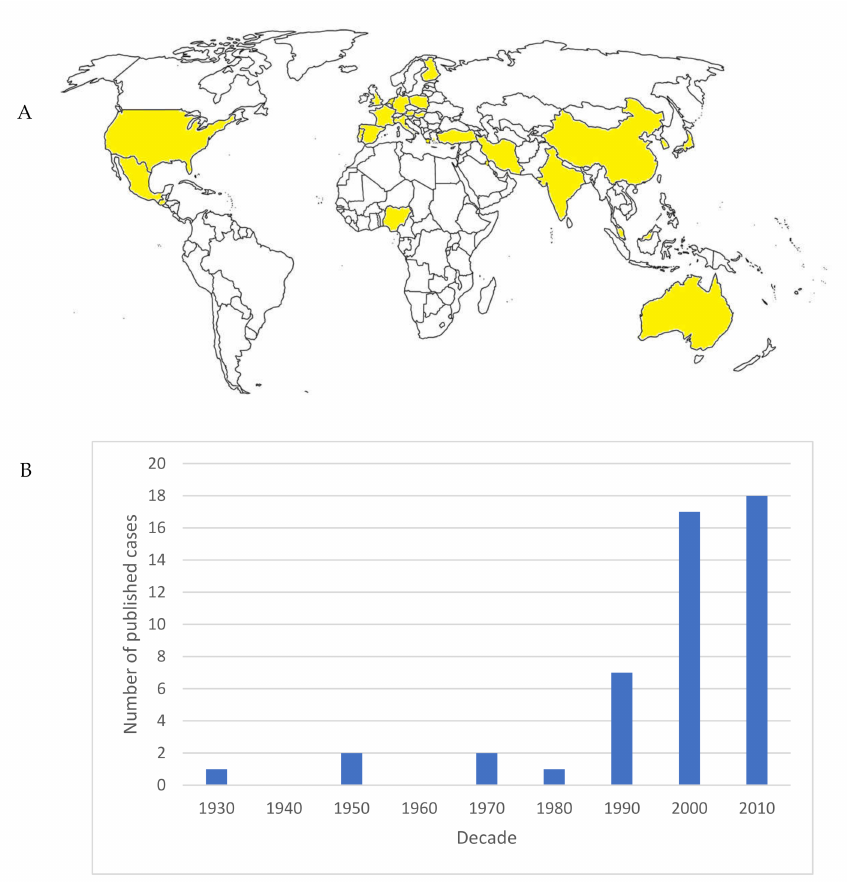
Figure 1. ( A ) Map showing the countries were rare Cryptococcus spp. isolates were reported (high- lighted in yellow). ( B ) Published cases per